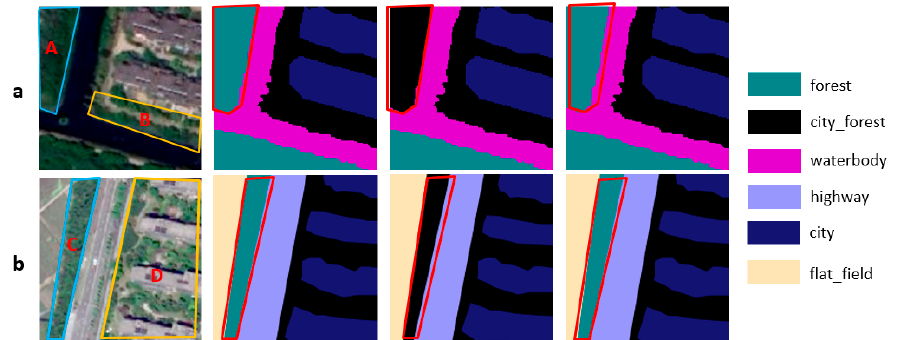
sified as city_forest in Cluster-GCN and classified correctly in KGGCN. In ( b ), forest (C) is misclas- sified as city_forest in Cluster-GCN, classified correctly in KGGCN.